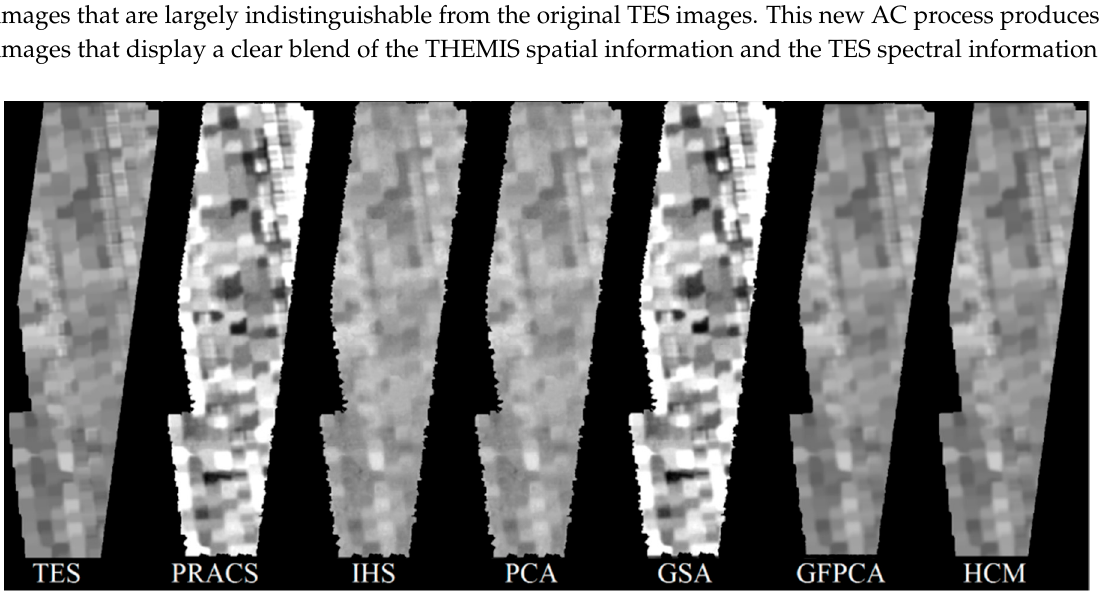
Figure 18. Original TES band 42 and the pansharpened Images across pansharpening algorithms. Table 2. Performance Metrics for Filtered THEMIS + Filtered TES (TES Filtered during Pansharpening).